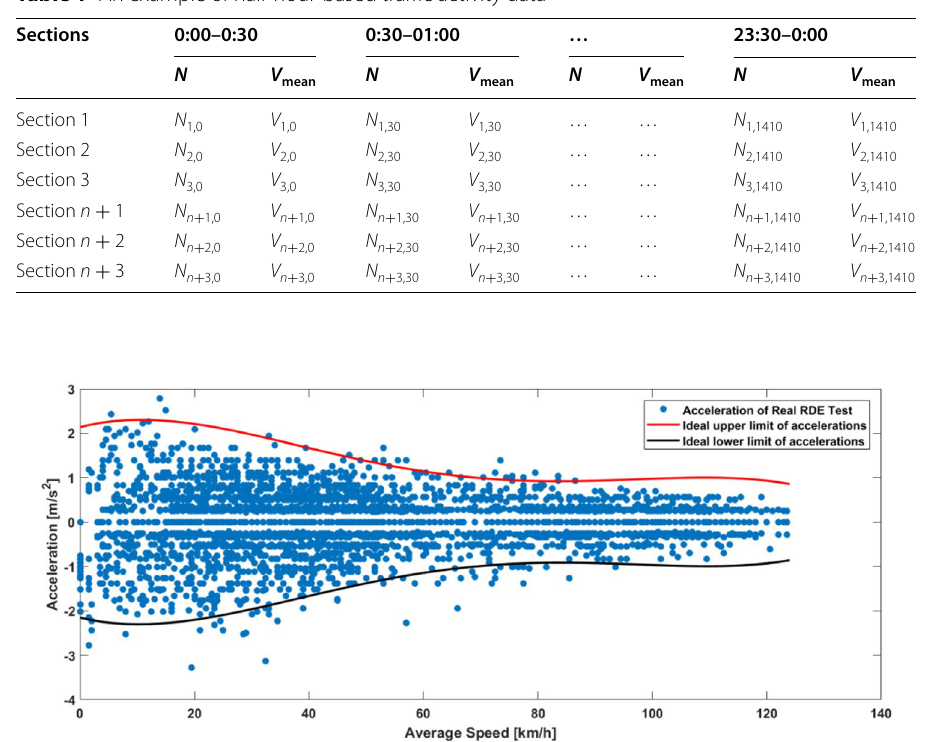
Fig. 2 Acceleration—speed distribution obtained in tests done on real traffic